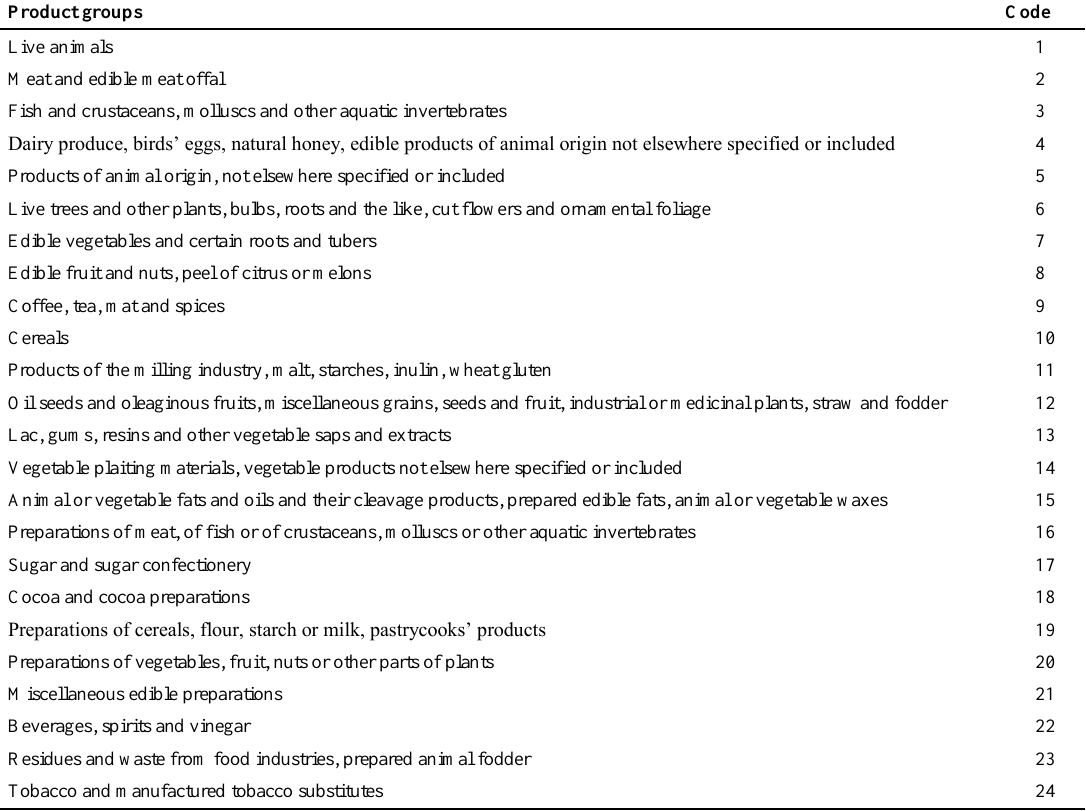
Table 1. Codes of product groups by HS-2 classification [18]